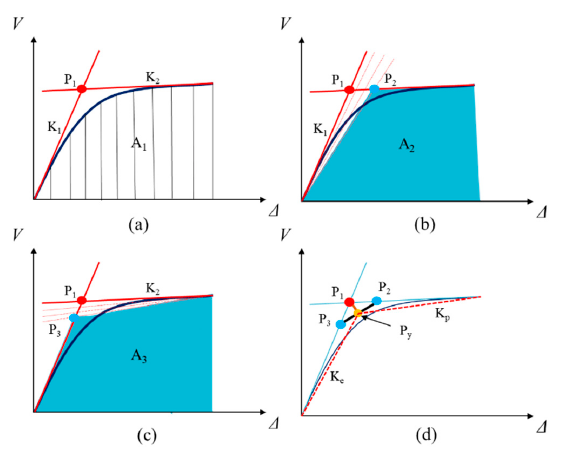
Figure 14. Schematic illustration of acquiring the yielding point in this study ( V is the base shear and Δ is the relative displacement between pier top and bottom). ( a ) Initial and yielding stiffness. ( b ) Illustration of P 2 point. ( c ) Illustration of P 3 point. ( d ) Illustration of yielding point.